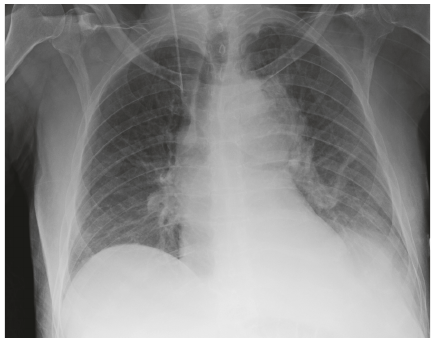
Figure 1: Chest radiograph showing widened mediastinum.